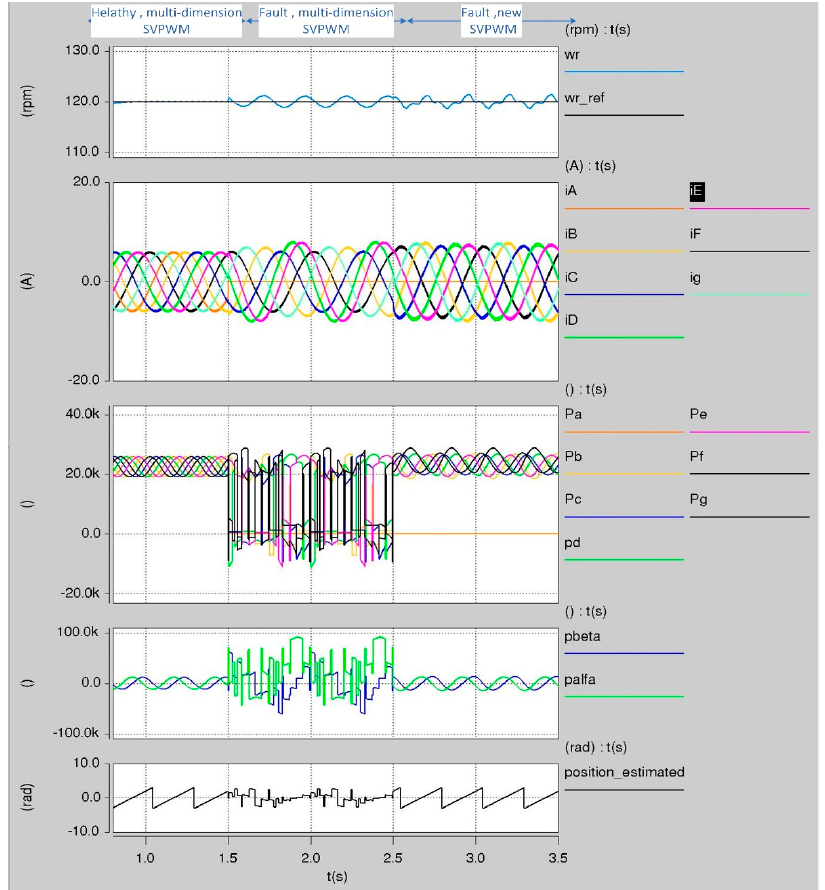
Figure 17. Tracking the saliency of the seven ‐ phase drive pre and post the losing of phase